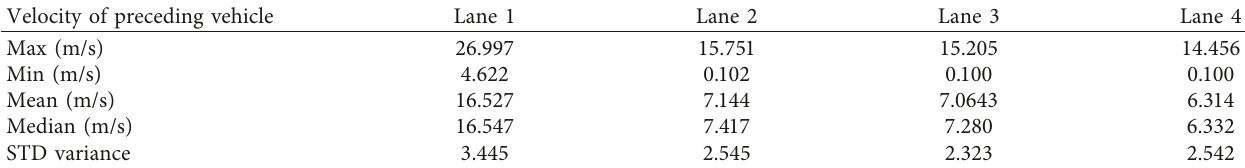
Table 3: Detailed information on the velocity of the preceding vehicle in different lanes.